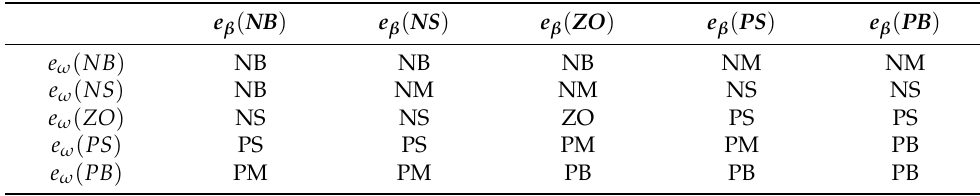
Table 3. The designed fuzzy controller determines M d in real time according to ∆ γ and ∆ β . Table 3. Fuzzy inference rules of the expected yaw